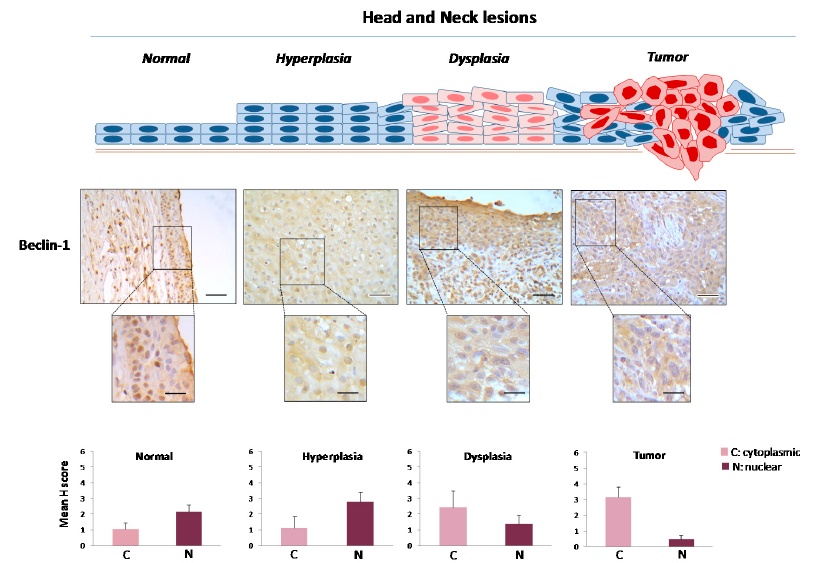
Figure 4. Immunohistochemical expression patterns of Beclin-1 in head and neck lesions. Representative images of cytoplasmic and nuclear immunohistochemical localization of Beclin-1 in normal laryngeal epithelium, hyperplastic and dysplastic lesions, as well as in tumor areas from the same patient. Bars in the histograms denote the cytoplasmic and nuclear mHscores of Beclin-1 in each stage (± SE: standard error). Blue cells in two lines depict normal laryngeal epithelium; blue cells in four lines depict hyperplastic epithelium; pink cells depict dysplastic epithelium; pink cells with red nuclei depict cancer cells. Scale bars: 100 μ m; scale bars of insets: 50 μ m.